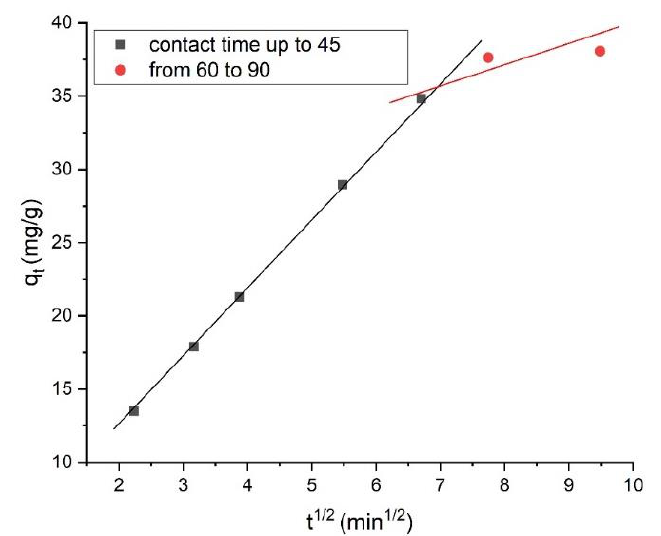
Fig. 4. Correlation of experimental data of adsorption kinetics of the Weber-Morris model.